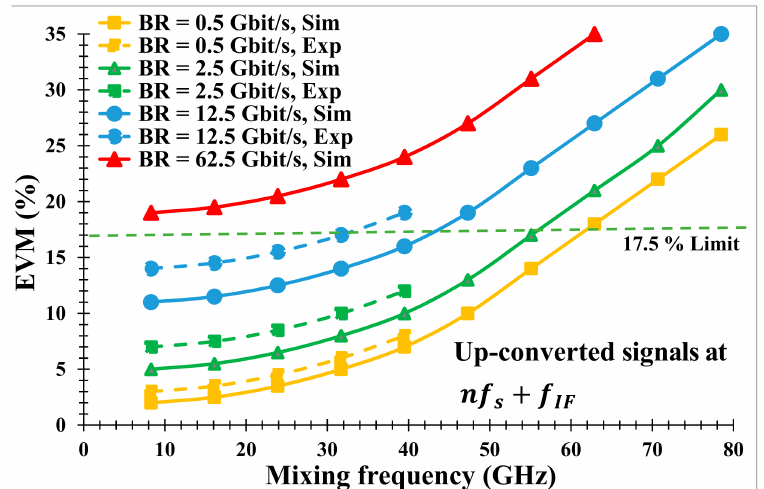
Figure 11. EVM of up-converted QPSK signals from f IF = 0.5 GHz to the mixing frequencies nf s + f IF for various bit rates for simulation (Sim) and experimental (Exp)